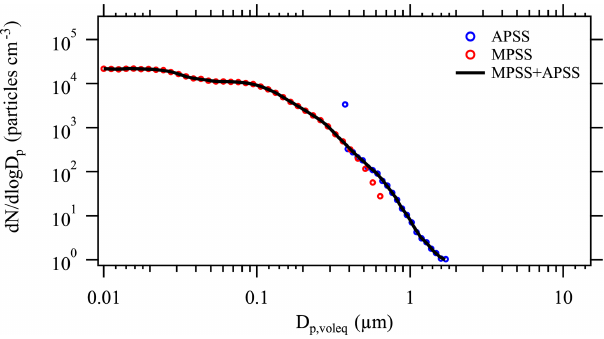
Figure 6. Illustration of the procedure of merging the PNSDs of MPSS and APSS.